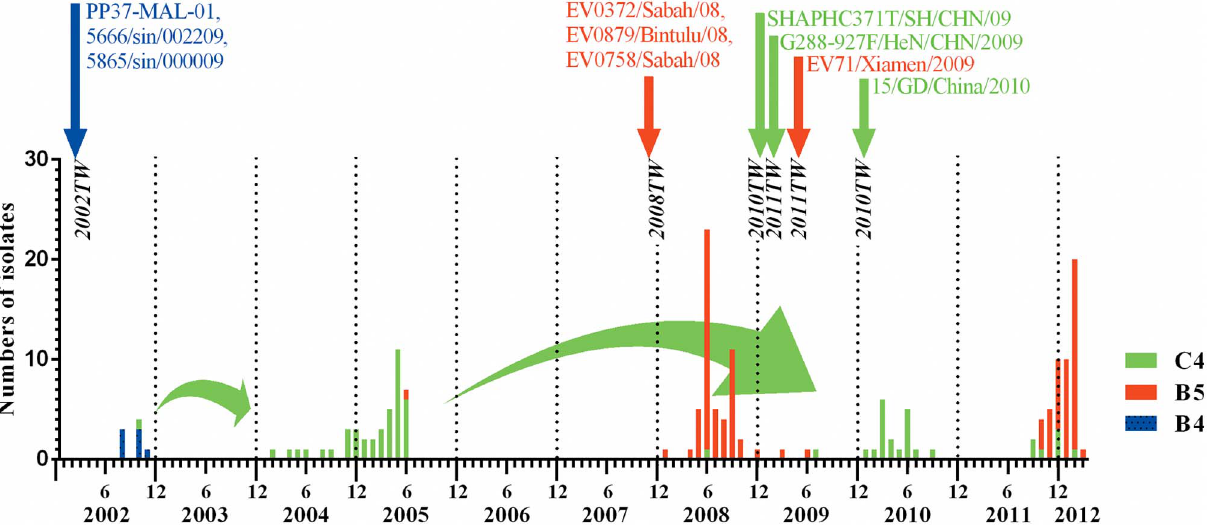
Figure 2. Temporal distribution of different EV71 subtypes in Taiwan from 2002 to 2012 and their possible origins.